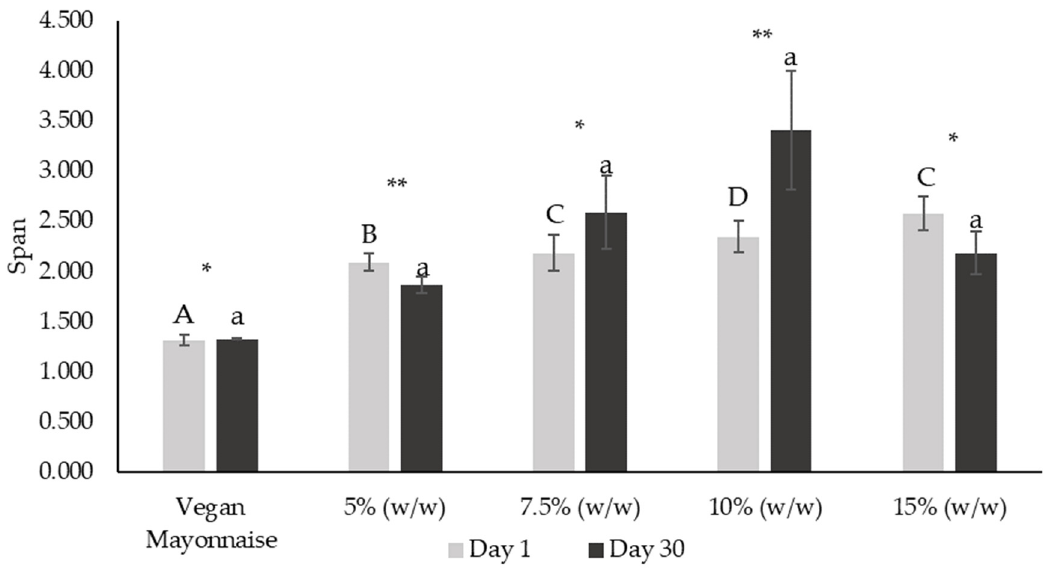
Figure 9. Span parameter from droplet size distribution of emulsions with 5, 7.5, 10 and 15% ( w / w ) of miso paste and standard emulsion, measured 1 and 30 days after emulsion preparation. Different letters indicate significantly different results ( p < 0.05) according to Tukey test. One asterisk and two asterisks represent non significantly ( p > 0.05) and significantly ( p < 0.05) different results, respectively, according to the t -Test.